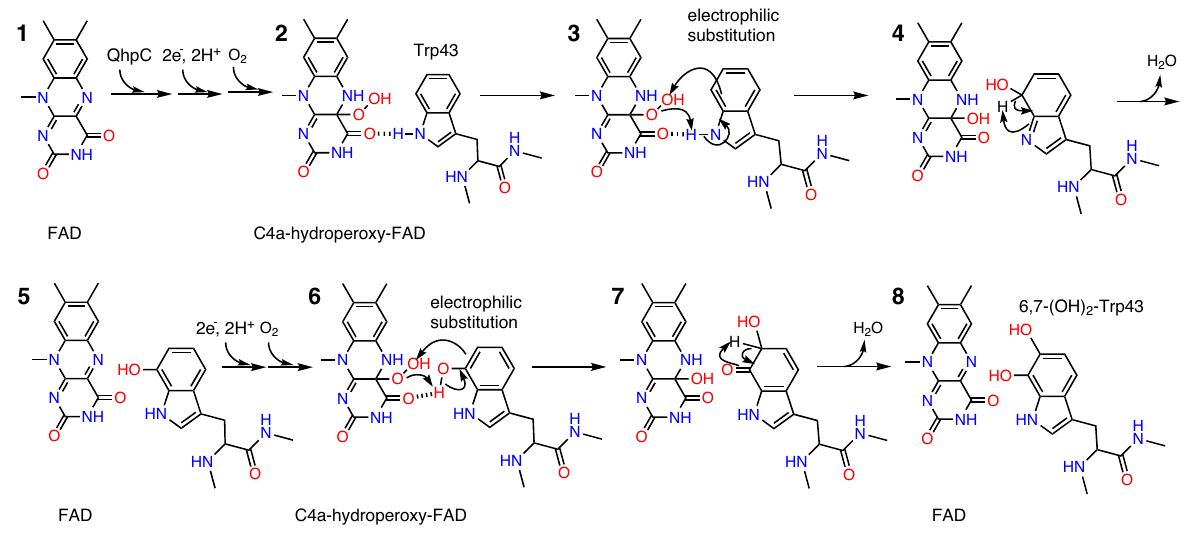
Fig. 7 Predicted reaction mechanism of QhpG. Details are described in the text